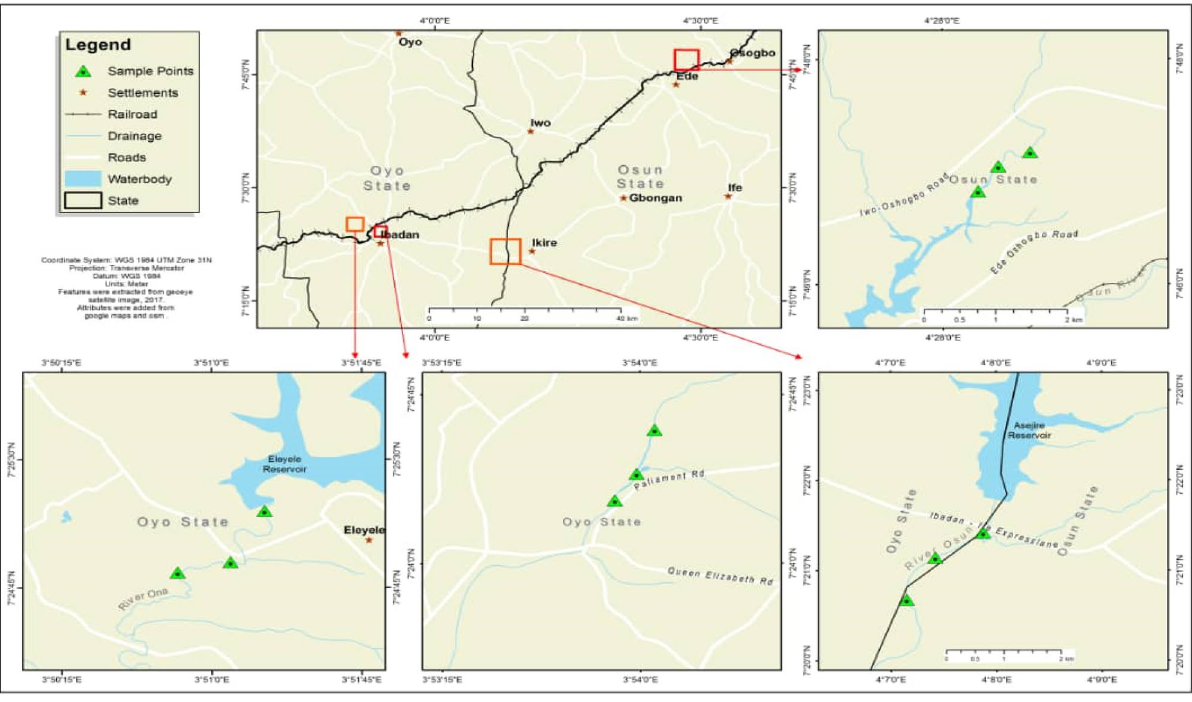
Figure 1. Map showing the four sampled